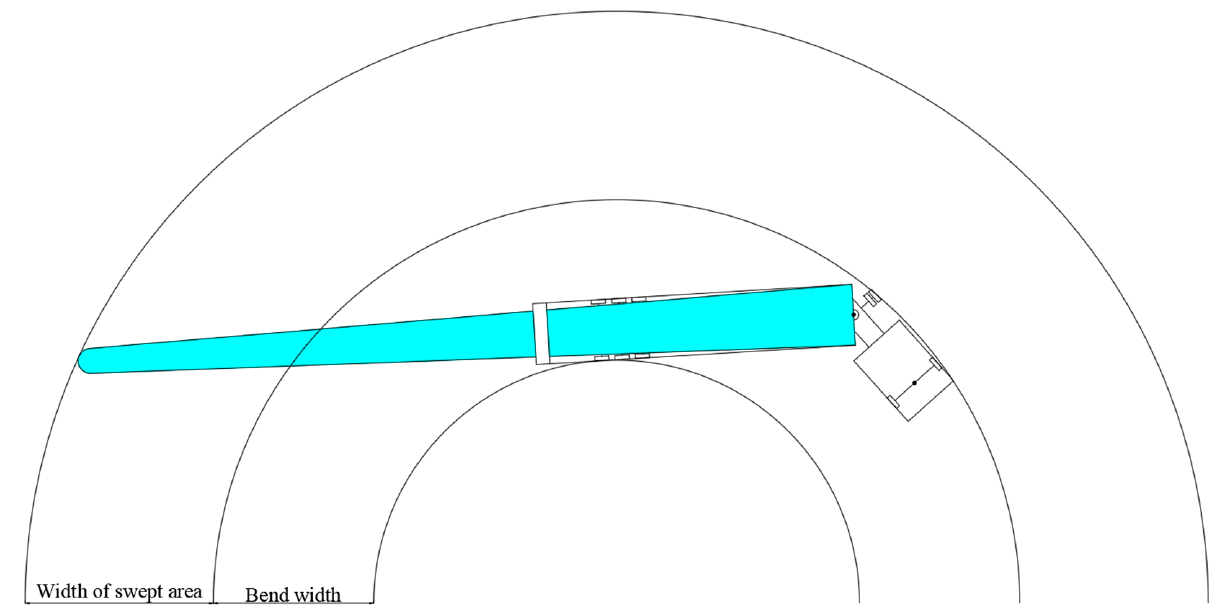
Figure 8. A schematic diagram of fl at truck transportation of wind turbine blades.